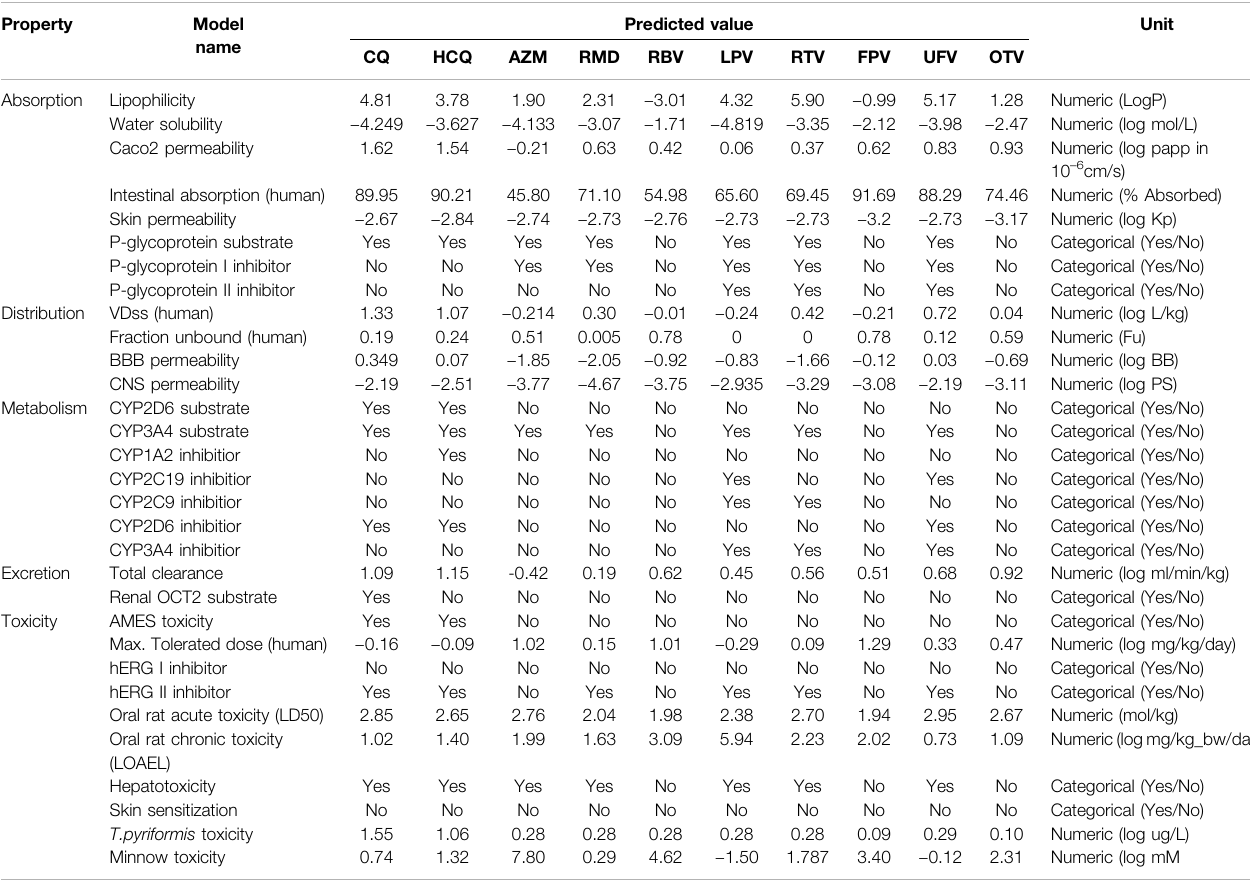
TABLE 2 | ADMET analysis of drugs repurposed against SARS-CoV-2.